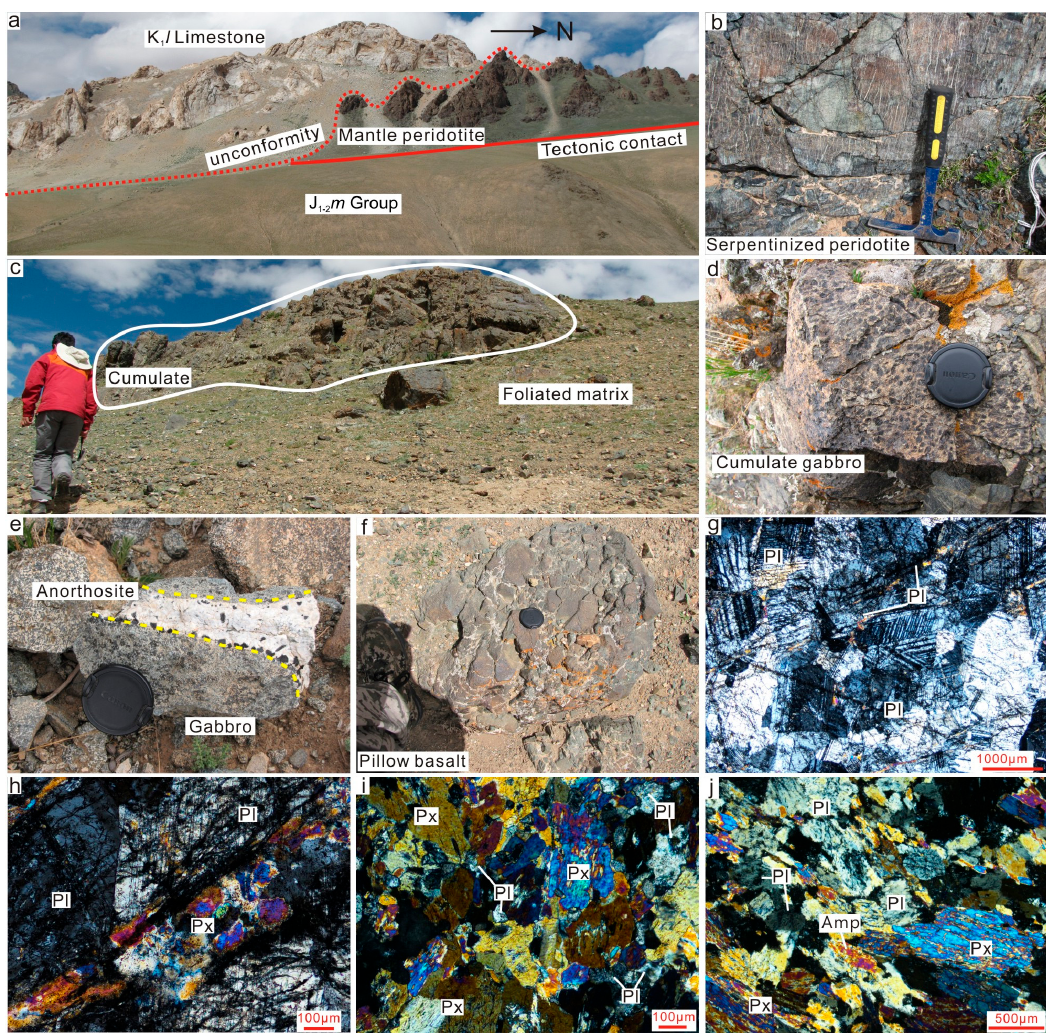
Figure 3. Field photographs ( a – f ) and micrographs ( g – j ) of the Dongco ophiolites. ( a ) Mantle peridotites unconformably overlain by the K 1 l limestones and in tectonic contact with the J 1–2 m formation; ( b ) serpentinized peridotite; ( c ) a block of cumulate rocks within a foliated mélange matrix; ( d ) cumulate gabbro; ( e ) massive gabbro intruded by anorthosite; ( f ) pillow basalt; ( g , h ) photomicrographs of anorthosite; ( i,j ) photomicrographs of gabbro. Note: ( a ) The mantle peridotite is about 500 m long, the red solid line corresponds to tectonic contact, and the red dashed line represents an angular unconformity; ( c ) the white solid line represents boundary of cumulate and foliated matrix; ( d – f ) diameter of the camera lens cap is 67 mm; ( e ) the yellow dashed marks the contacts between gabbro and anorthosite. Abbreviations: Pl, plagioclase; Px, pyroxene; Amp, amphibole.